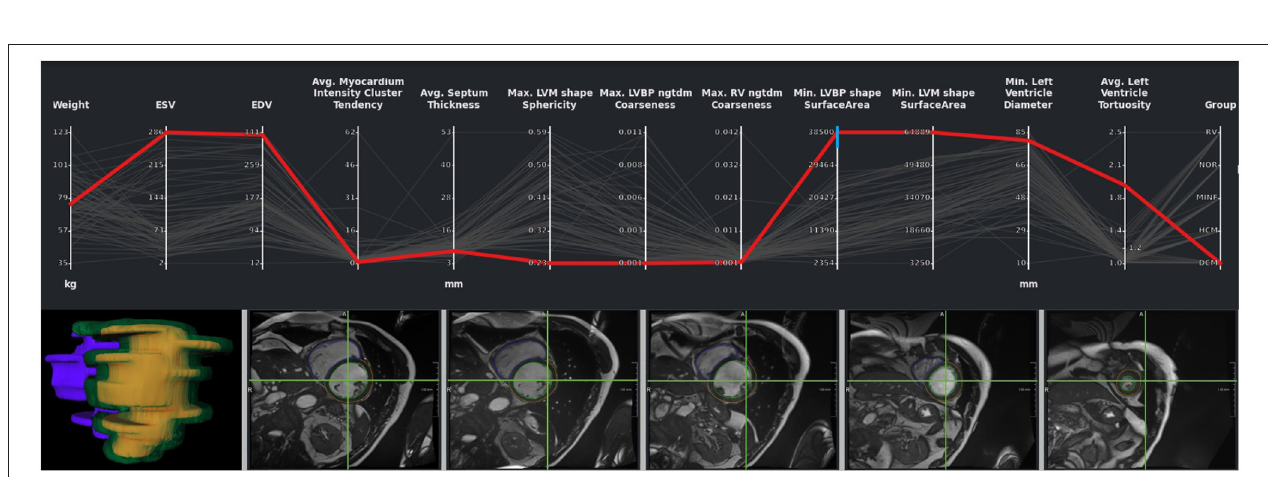
FIGURE 9 | Outlier with motion artifacts. Changes in the left endocardial and epicardial surface area indicate the presence of an outlier. The 3D rendering of the segmentation surface highlights the misaligned slices. The green crosshair in the image viewers was placed in the center of the left blood pool in a basal slice, giving an impression of the motion of the blood pool